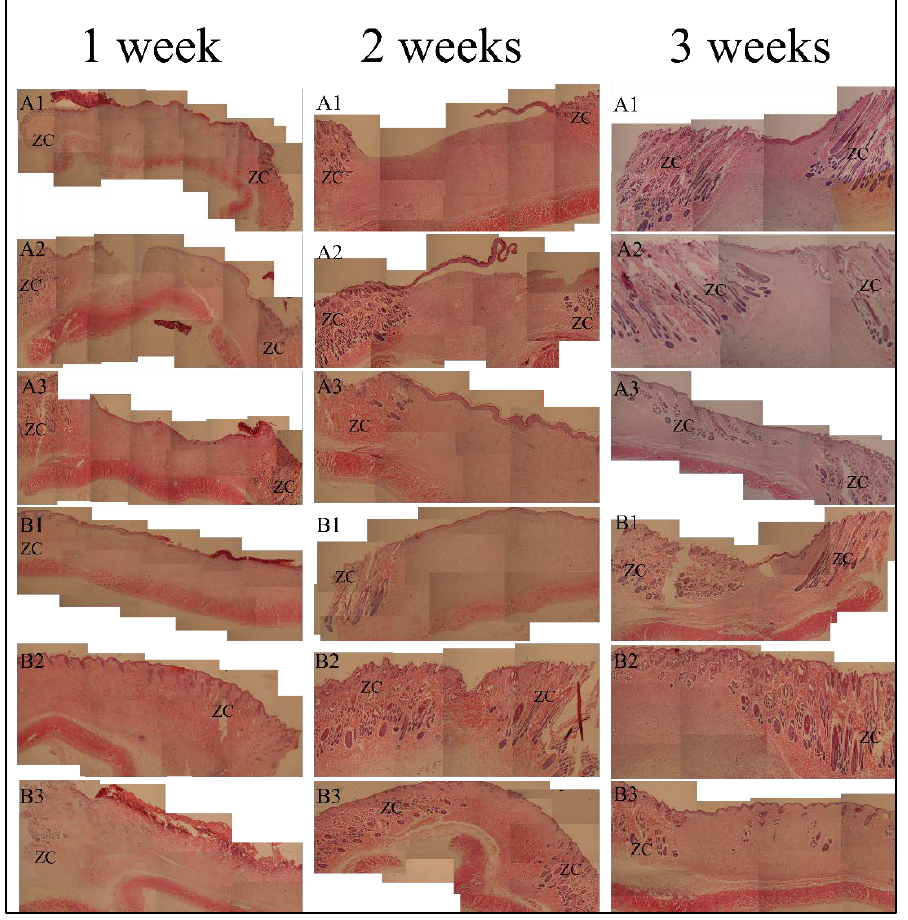
Figure 6. The observation results of HE at 1 week, 2 weeks, and 3 weeks (×40, ZC stands for normal tissue). A1 is the SC16:1 composite hydrogel membrane; A2 is the SC8:1 composite hydrogel membrane; A3 is the SC4:1 composite hydrogel membrane; B1 is a blank control group; B2 and B3 are two autologous skin transplantation control groups.